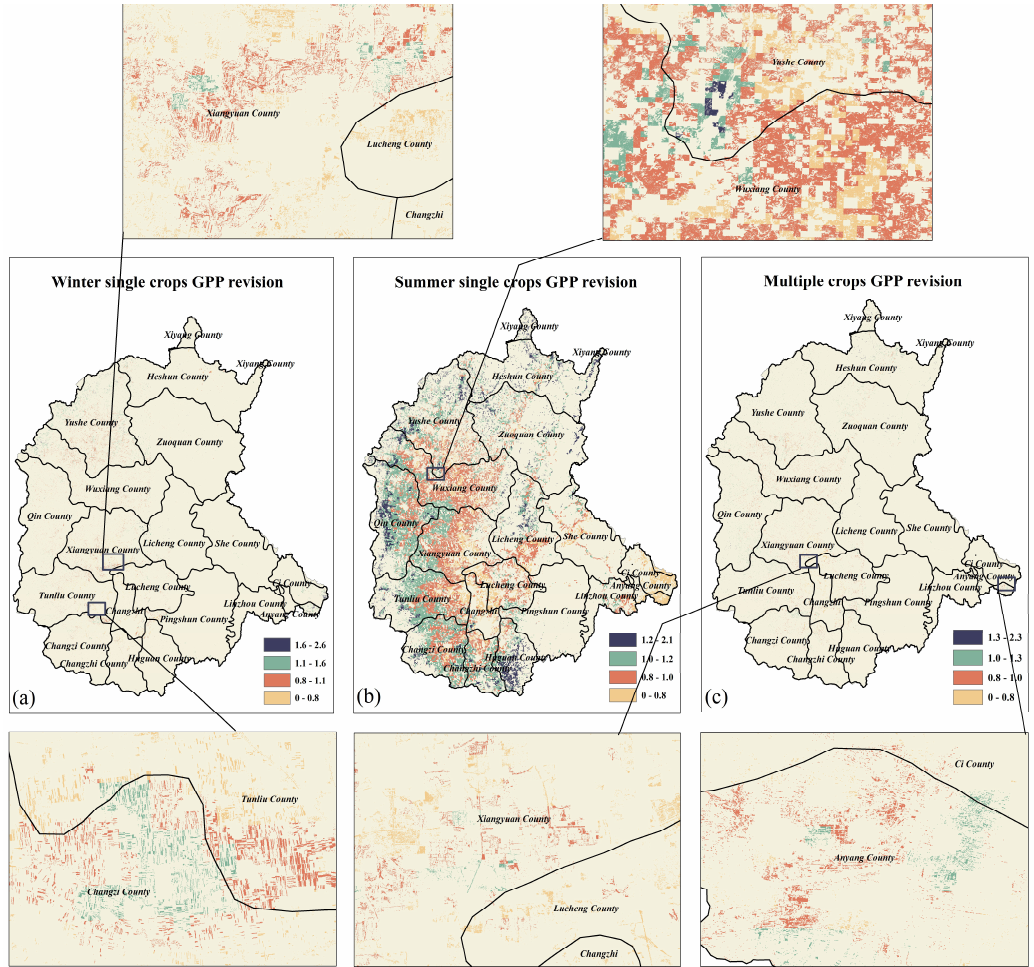
Figure 11. Spatial difference of crop growth in the Yuecheng Reservoir catchment area. (a) Winter single crops GPP revision. ( b ) Summer single crops GPP revision. ( c ) Multiple crops GPP single crops GPP revision. (b) Summer single crops GPP revision. (c) Multiple crops GPP revision.